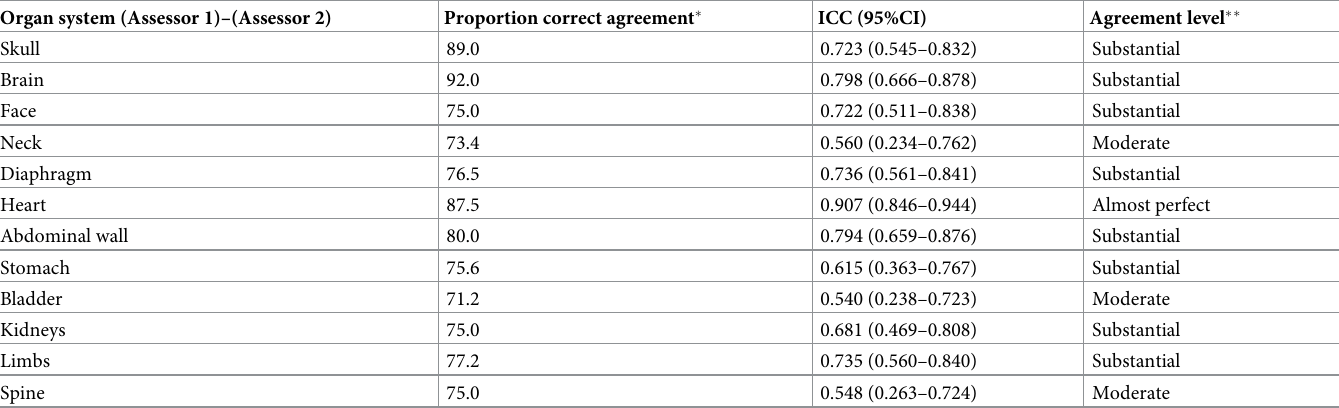
Table 4. Agreement analysis per organ system–intraclass correlation coefficient (ICC). Organ system (Assessor 1)–(Assessor 2)